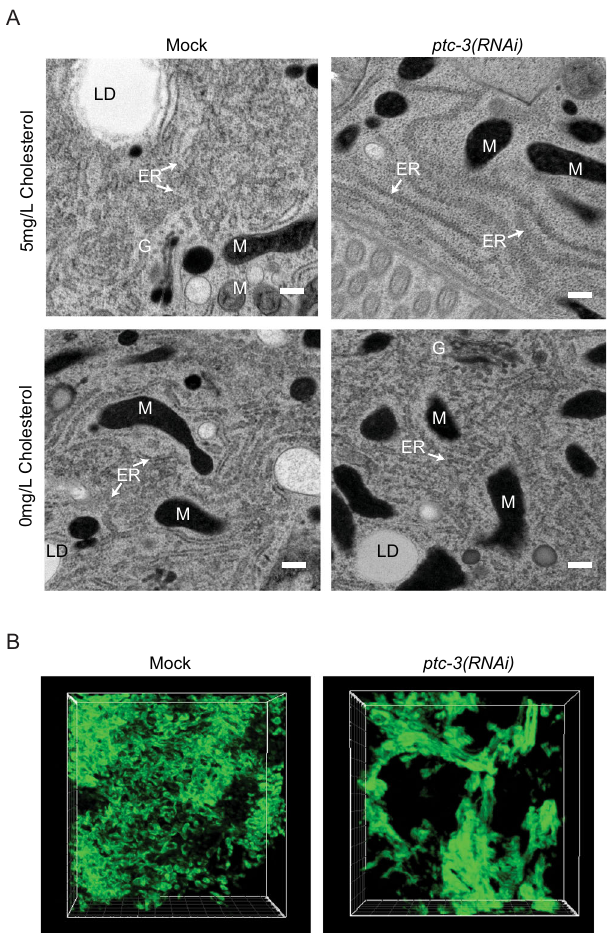
Fig. 4 ptc-3(RNAi) reduces LD in the gut and induces changes in the ER structure. A Transmission electron microscopy (TEM) of adult mock and ptc-3(RNAi) treated animals after L2 stage reveal a reduction of reticulate ER structures and LD in ptc-3(RNAi) animals. This phenotype is rescued by the omission of cholesterol in the medium. ER endoplasmic reticulum, LD lipid droplet, M mitochondria, G Golgi. Scale bars 200 nm. n = 4 (mock) and 6 ( ptc-3(RNAi )) animals. B Reconstitution of ER membranes from FIB- SEM images of mock and ptc-3(RNAi) treated animals using machine learning. ptc-3(RNAi) induces sheet-like ER